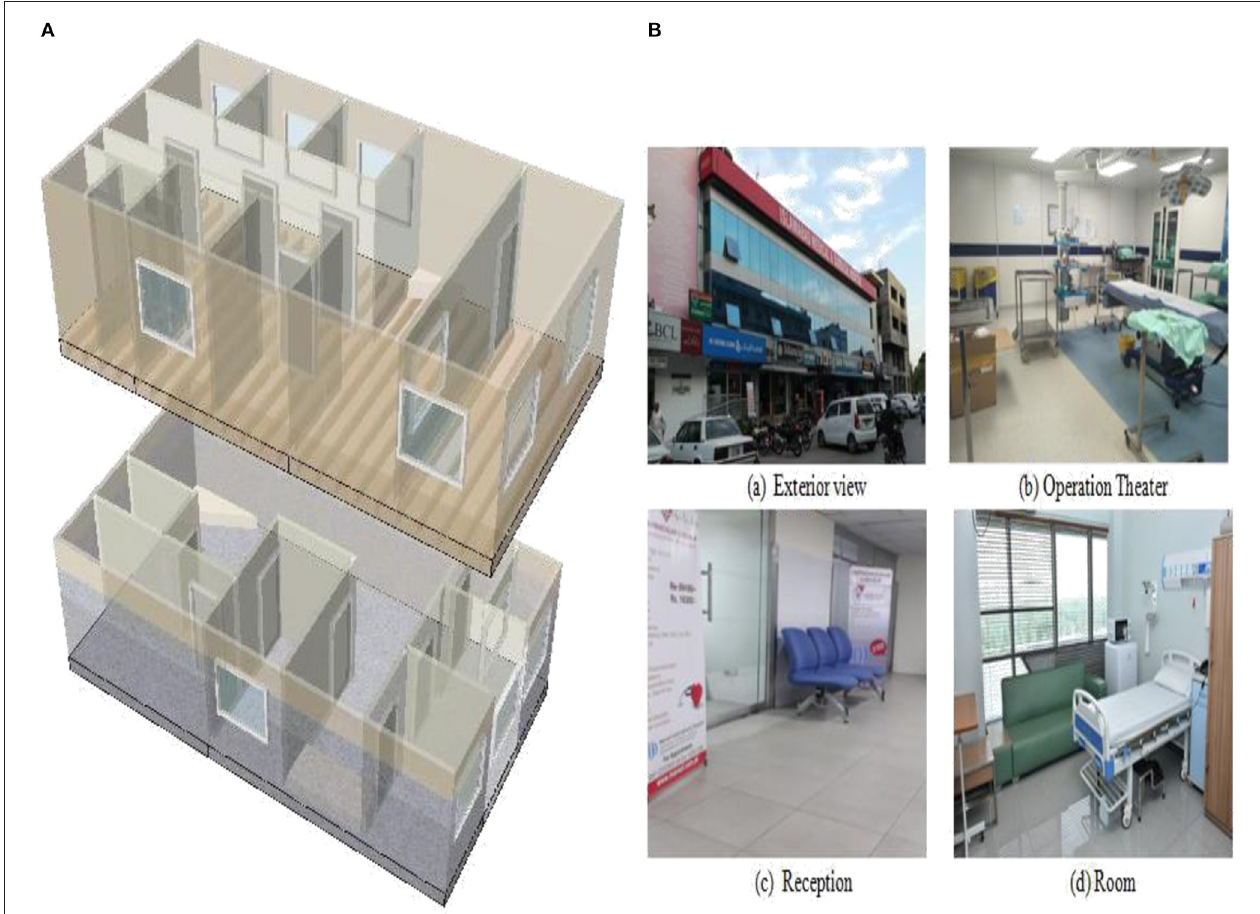
FIGURE 4 | Selected hospital building. (A) 3D model of the building. (B) Real hospital